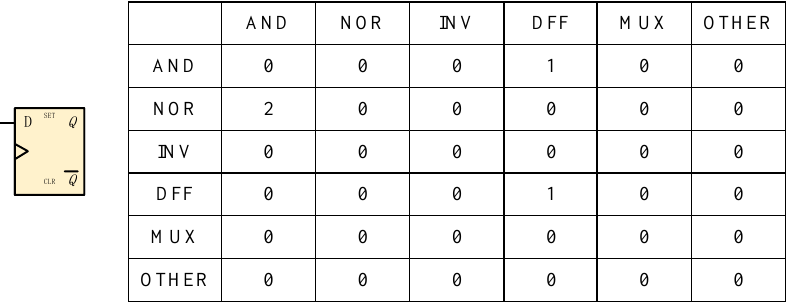
Figure 4. Example of the co-occurrence